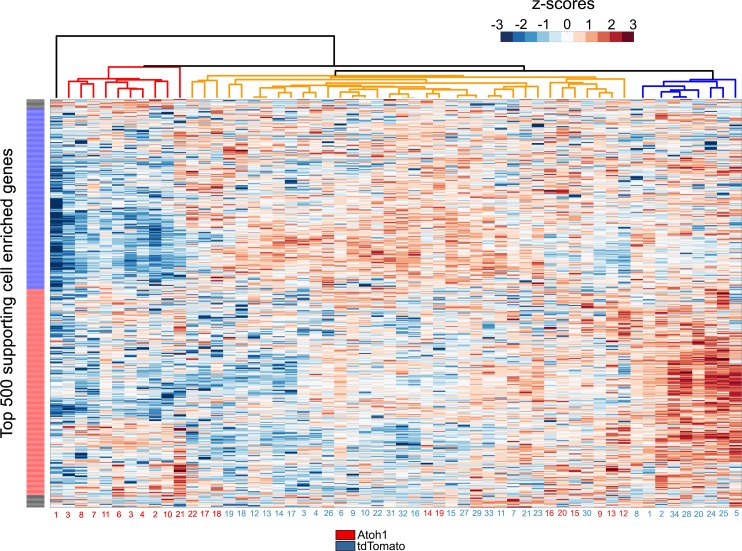
Single Cell RNA-seq analysis reveals Atoh1 transduction down-regulate supporting cell enriched genes.Heat map shows hierarchical clustering of gene expression level between each single cells (Ad-tdTomato-Atoh1 infected cells labeled in red, and Ad-tdTomato infected supporting cell labeled in blue) for top 500 utricle supporting cell enriched genes. The color code on the left indicates suggested clustered genes population the hierarchical clustering of cells is shown by a dendrogram at the top of the panel.